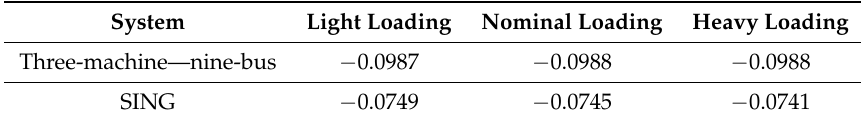
Table 7. Real part closest to the